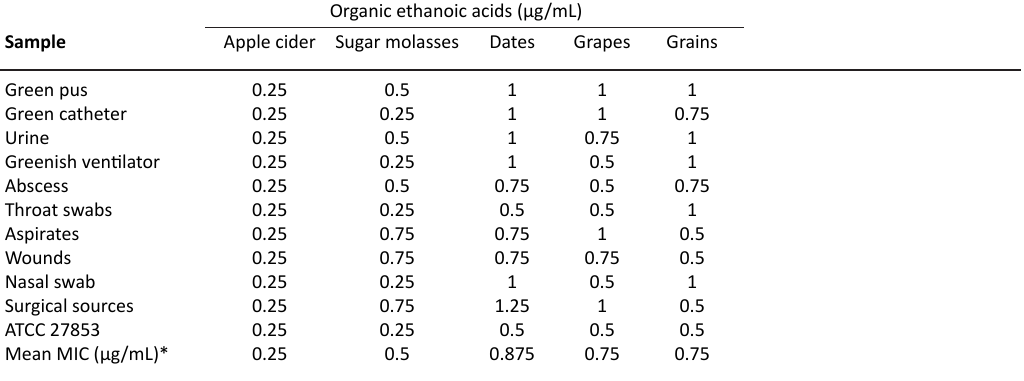
MIC, minimum inhibitory concentrations. *Derived from all